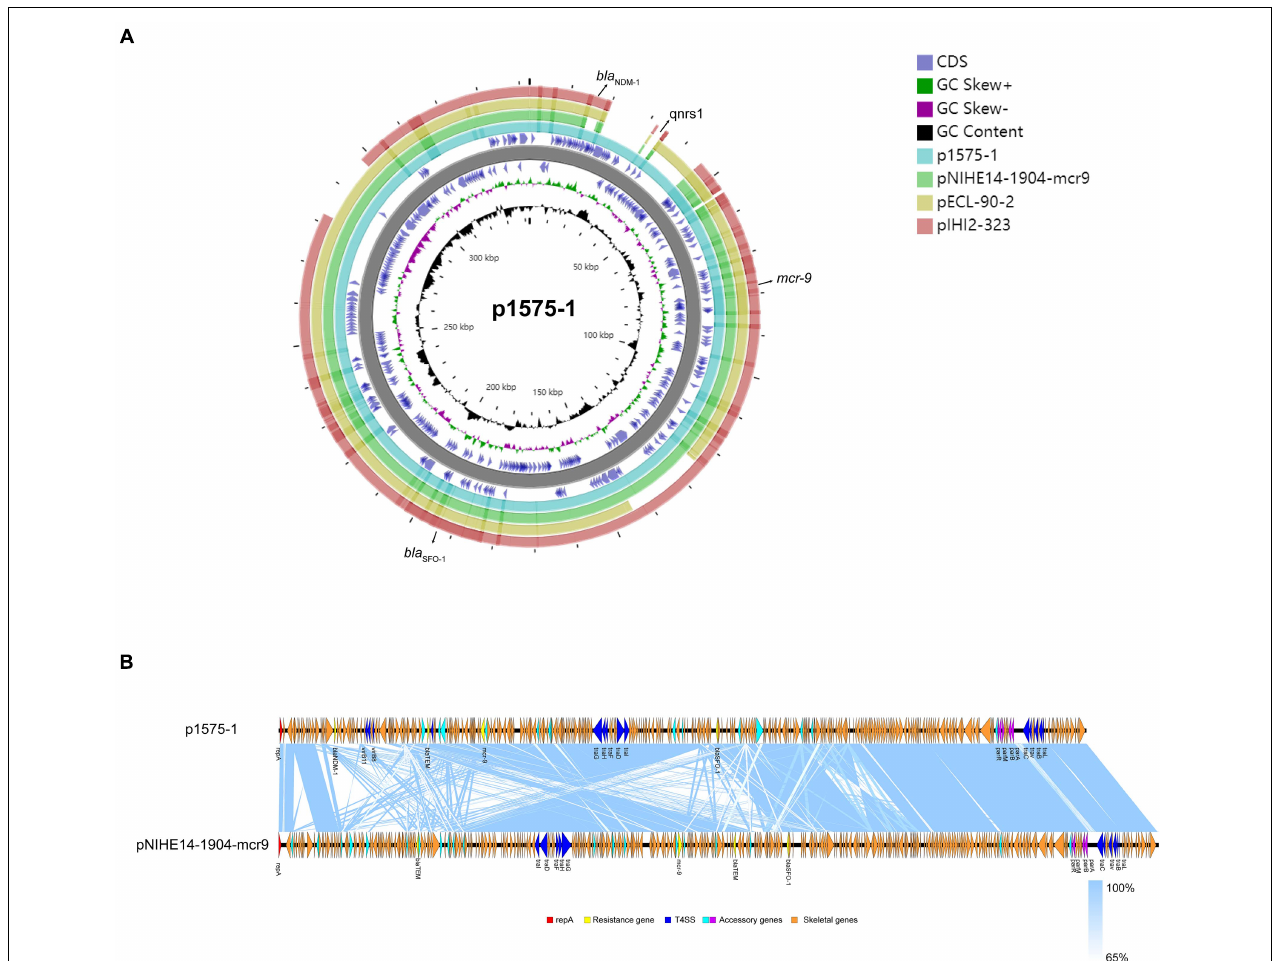
FIGURE 2 | (A) Ring diagram representation of plasmid p1575-1. From the inside to the outside, the first circle represents the scale; the second circle represents GC content; the third circle represents the GC skew; the fourth and sixth circles represent the COG to which each CDS belongs; the fifth circle represents the backbone; the seventh to 10th circles represent p1575-1, pNIHE14-1904-mcr9, pECL-90-2, and pIHI2-323, respectively. GC, guanine + cytosine; bla SFO − 1 , extended-spectrum β -lactamases (ESBLs); bla NDM − 1 , New Delhi metallo- β -lactamase-1 gene; mcr-9 , colistin resistance gene; qnrs1 , fluoroquinolones gene. (B) Comparative analysis of the mcr-9 -harboring plasmid characterized in this study with closely related plasmid pNIHE14-1904- mcr9 . Open reading frames (ORFs) are portrayed by arrows and are depicted in different colors based on their predicted gene functions. The genes associated with the T4SS are indicated by dark blue arrows, while the genes involved in replication are indicated by red arrows. Resistance genes are indicated by yellow arrows, and accessory genes are indicated by light blue and purple arrows. Orange arrows represent the skeletal gene of the plasmid, and blue shading denotes shared regions of homology among different